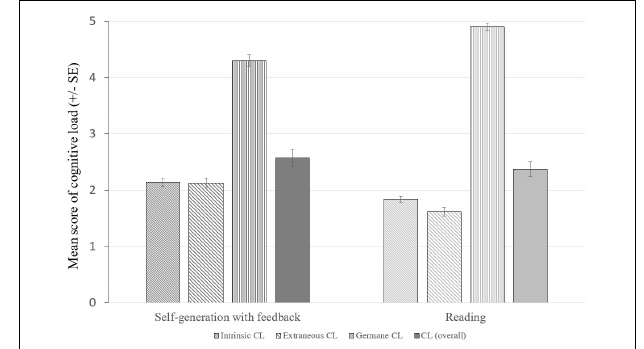
FIGURE 2 | Mean score of (intrinsic, extraneous, germane, overall) cognitive load by treatment (self-generation with feedback (GF), reading